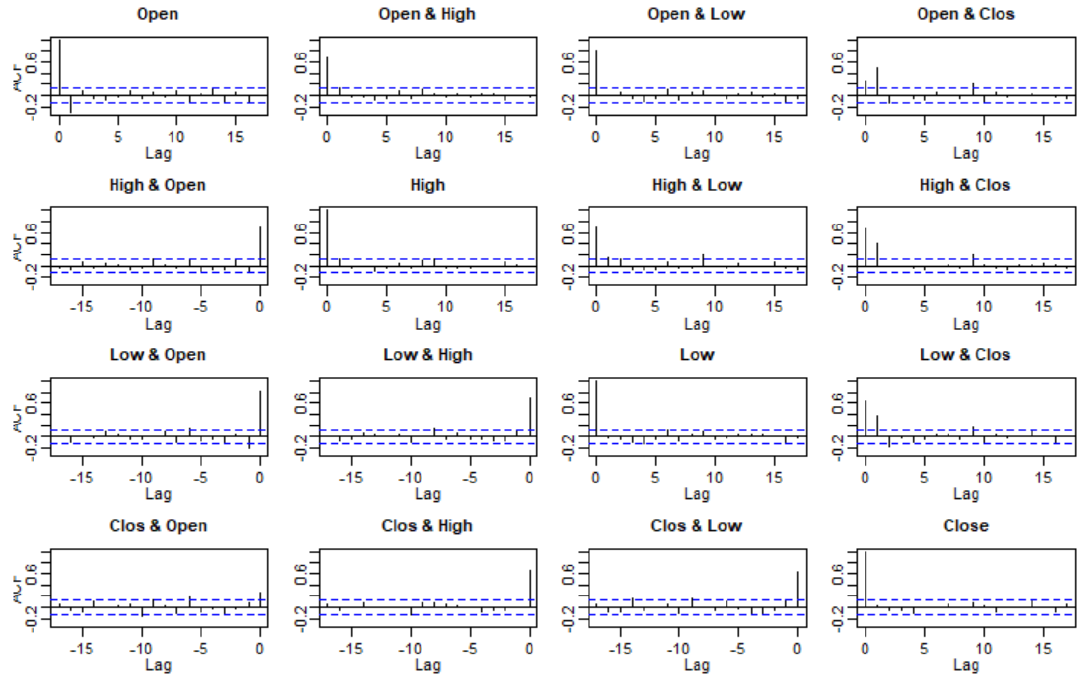
Figure 2. ACF test for correlation between open, low, high, and close of Apple stock daily return